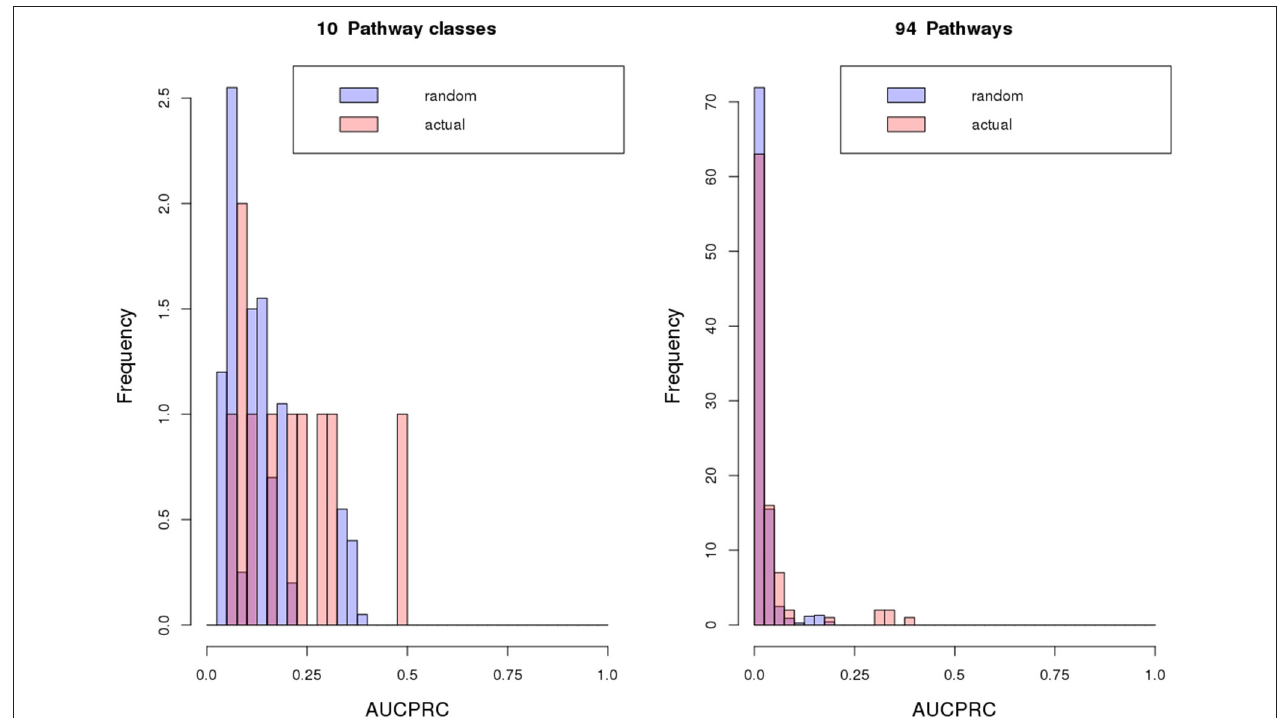
FIGURE 8 | Classification results. Classification results of metabolic pathway class or map assignments of gene objects based on their phylogenetic profiles using Random Forest predictions as implemented in Clus-HMC. Performance is judged by the area under the precision-recall curve (AUCPRC). For the 100/20 randomized repeats performed for pathway map or class respectively, average AUCPRC distributions are plotted. Averaged over all random repeat runs, tests for statistical difference (Wilcoxon rank sum test) between actual and random AUCPRC value distributions yielded for pathway class: mean actual = 0.2, mean random = 0.13, p = 0.22, and for pathway map: mean actual = 0.04, mean random = 0.021, p = 0.0033. Clus-HMC was used allowing multiple and hierarchically organized labels per object with the hierarchy related to metabolism class and metabolism map.